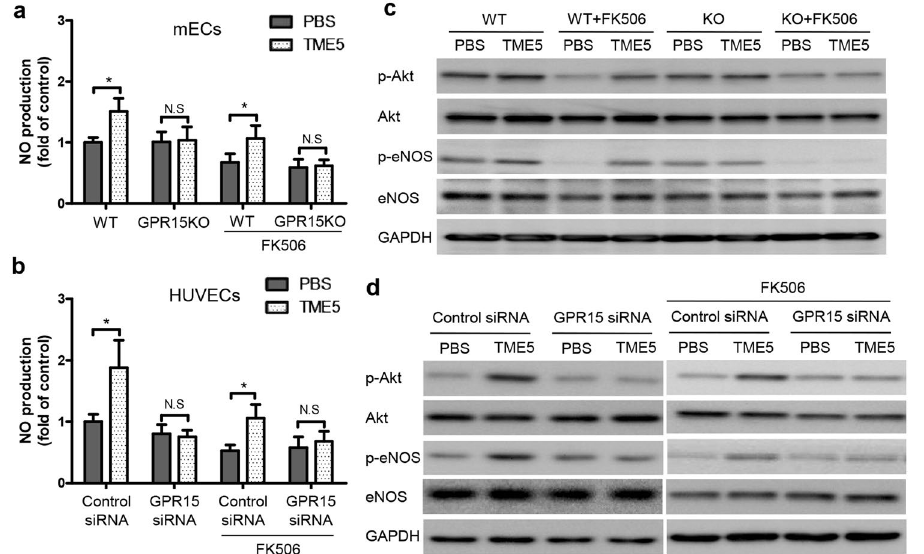
Figure 5. TME5 promotes production of NO in ECs. Murine ECs ( a ) as well as HUVECs ( b ) were incubated with PBS or TME5 (250 ng/ml) for 48 hrs, in the absence or presence of FK506 (10 μ g/ml). Supernatants were mixed with Griess reagent followed by reading the absorbance at 540 nm (n = 3 in each). Data are shown as mean ± SD, and are compared using one-way ANOVA test. * p < 0.05; N.S., no significance. Total proteins from murine ECs ( c ) and HUVECs ( d ) were analyzed by western blot with the indicated antibodies. Figure represents one from three independent